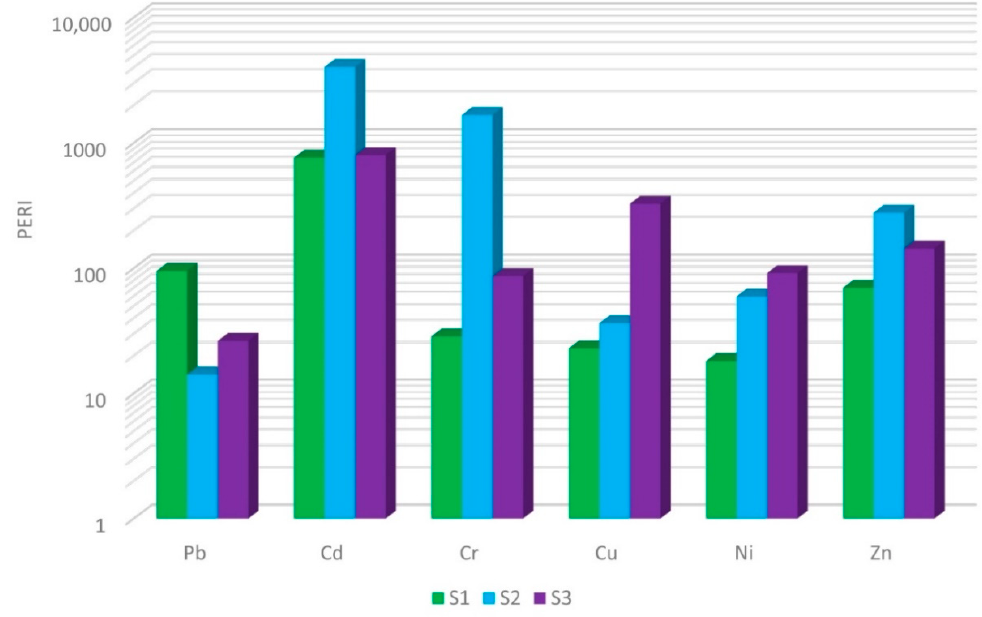
Figure 3. PERI of HMs in SS.